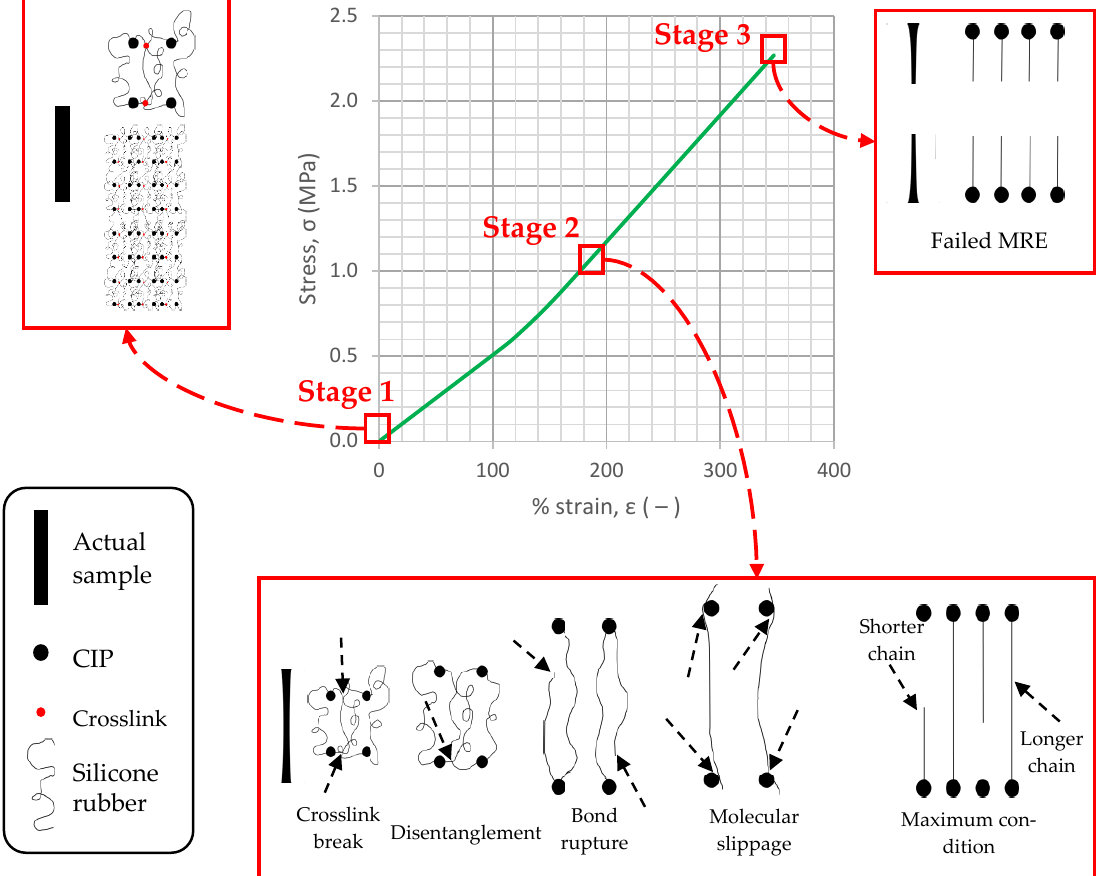
Figure 8. The mechanism underlying the stress – strain behavior of anisotropic silicone-based MREs with 10 vol.% CIP concentrations at off-state condition.